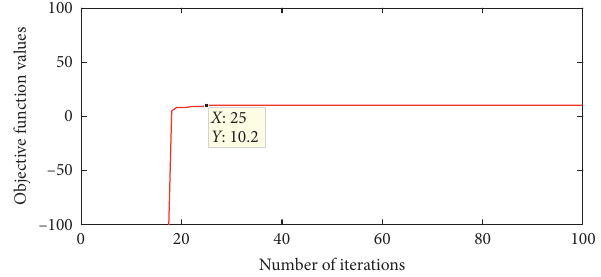
Figure 8: Convergence graph of BGSK.